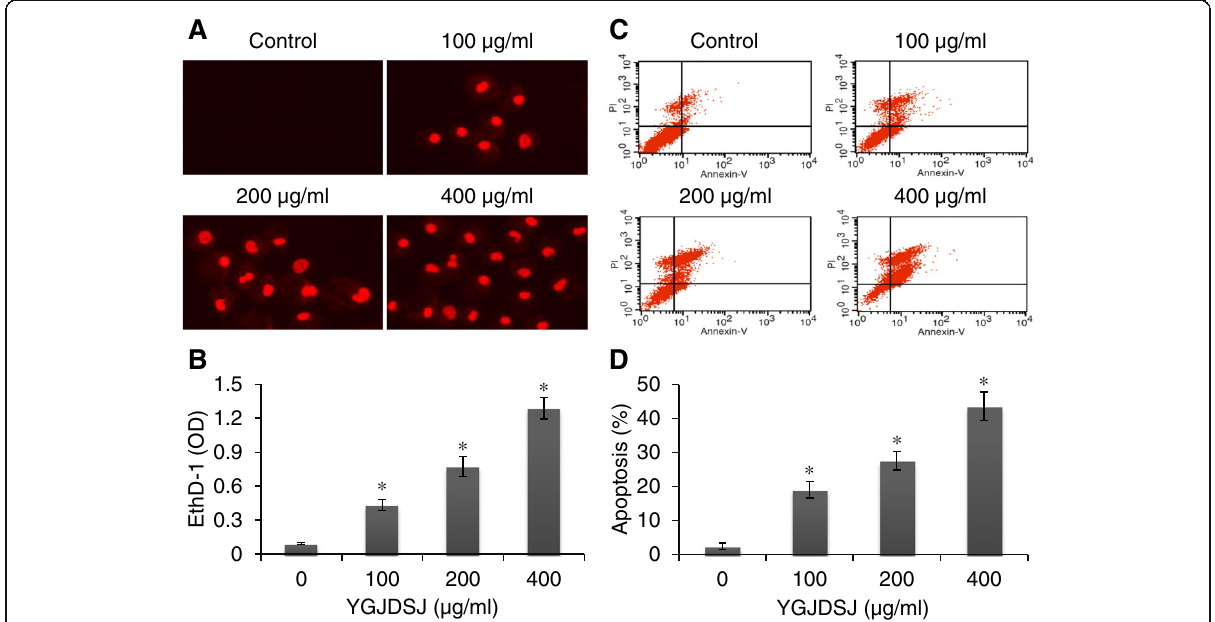
Fig. 2 YGJDSJ induced anoikis in Bel-7402 cells. Suspension-grown Bel-7402 cells were treated with different dose of YGJDSJ for 24 h, stained with EthD-1, and observed under fluorescence microscope (×200) ( a ), and quantitated with a fluorescence microplate reader ( b ). YGJDSJ treated or untreated Bel-7402 cells were stained with Annexin V-FITC/PI, analyzed in FACScalibour flow cytometer ( c ), and expressed as mean±SD ( d ). Data illustrated are from three separate experiments. * P <0.01, versus control